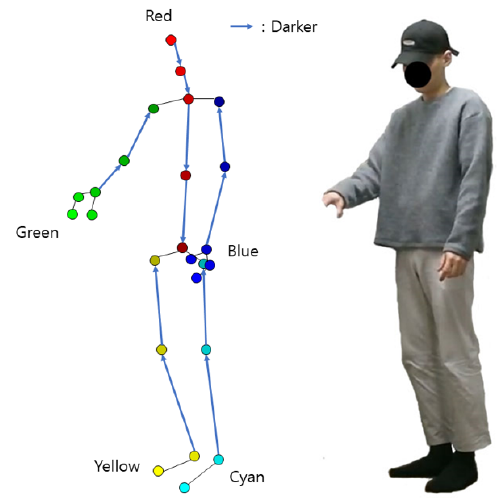
Figure 4. Color assignment of skeleton on a skeleton-heatmap.